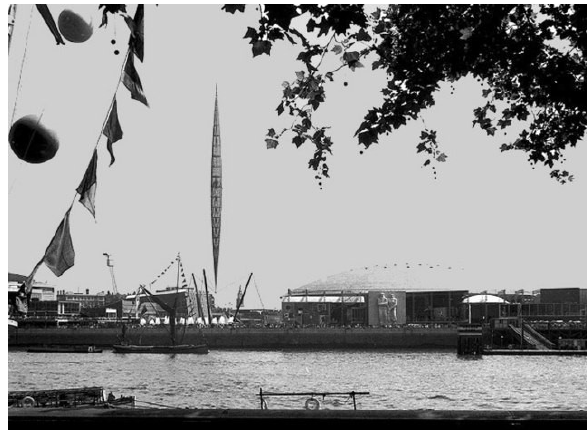
Figure 7: Dome of Discovery and The Skylon